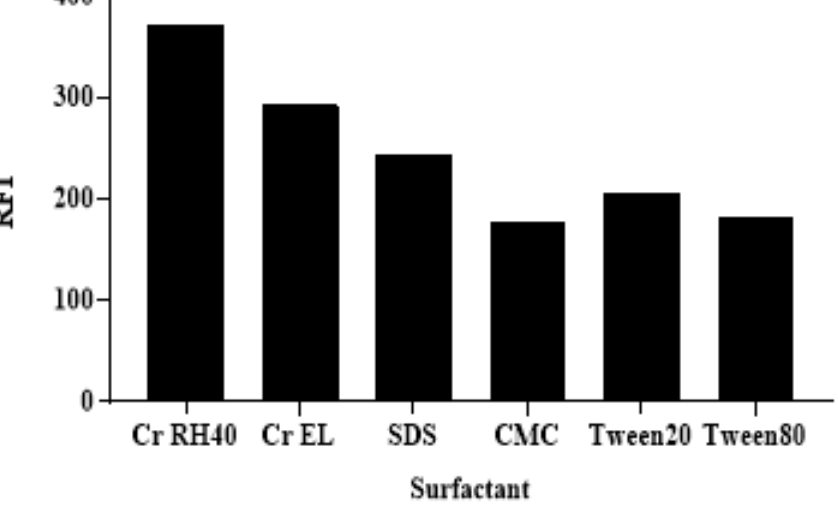
Figure 4. The effects of types of surfactant (1%, w / ν ) on the RFI of ALC (250 ng mL − 1 ).